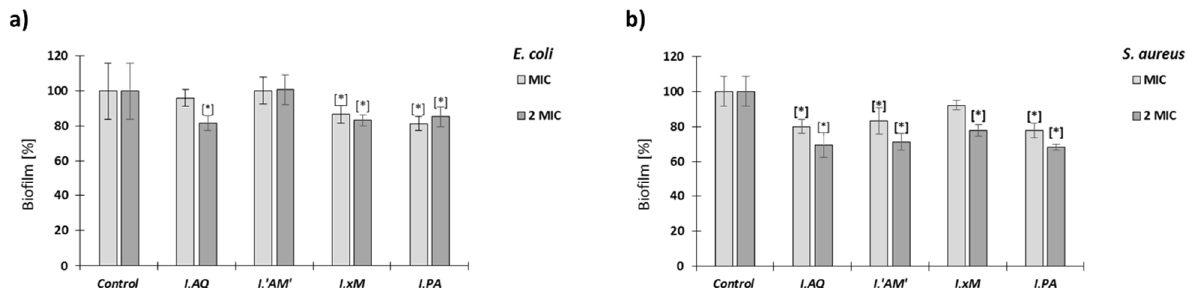
Figure 5. Influence of water Ilex extracts (MIC and 2 MIC) on biofilm eradication E . coli ( a ) and S . aureus ( b ) after 24 h. The control is biofilm not treated with extracts; mean ± SD, n = 3; * statistically different from the control p < 0.05. Legend: I.PA — I. paraguariensis ; I.AQ — I. aquifolium ; I.’AM’ — I. aquifolium ‘Argentea Marginata’; I. × M — I. × meserveae ‘Blue Angel’.